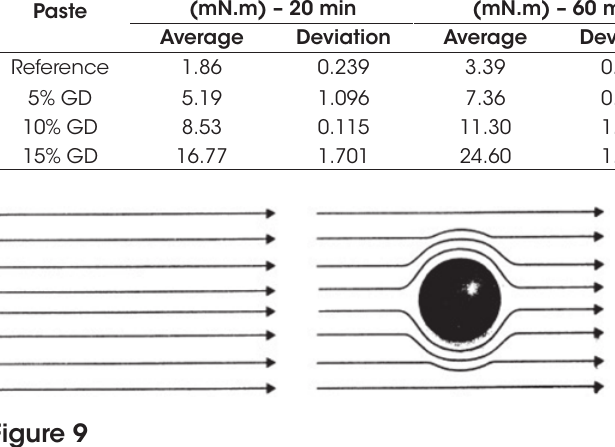
Effect of the presence of a spherical particle on the flow lines of a fluid subjected to shear.